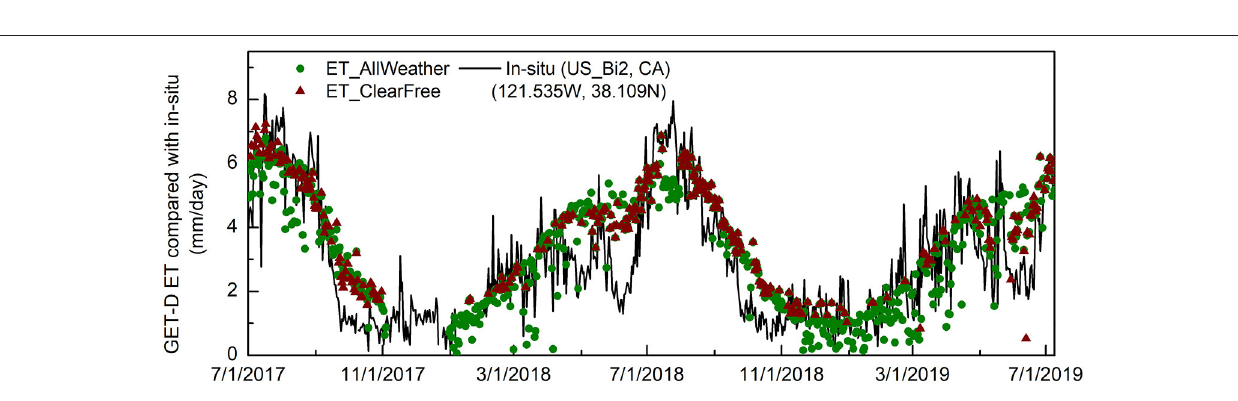
FIGURE 9 | Same as Figure 8 , but at the station (US-Bi2) in